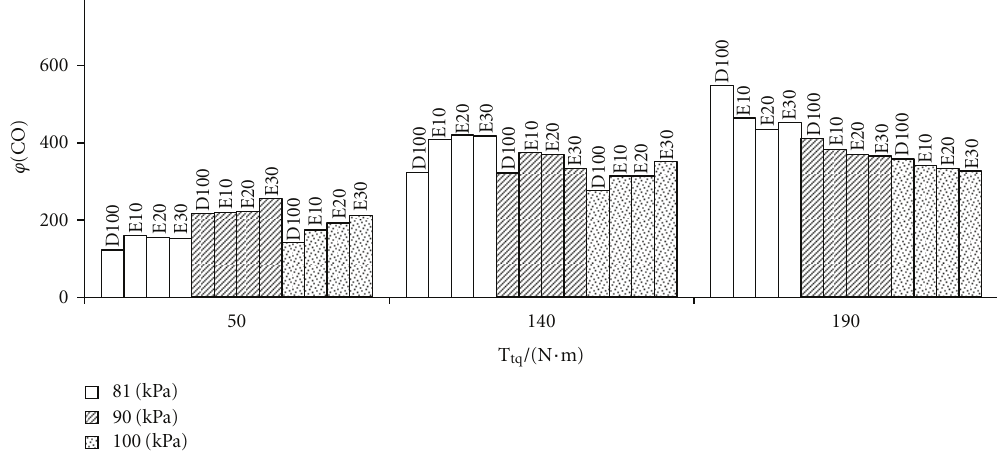
Figure 7: Comparison of CO emission of di ff erent atmospheric pressure and mix proportion at speed 3200r/min.